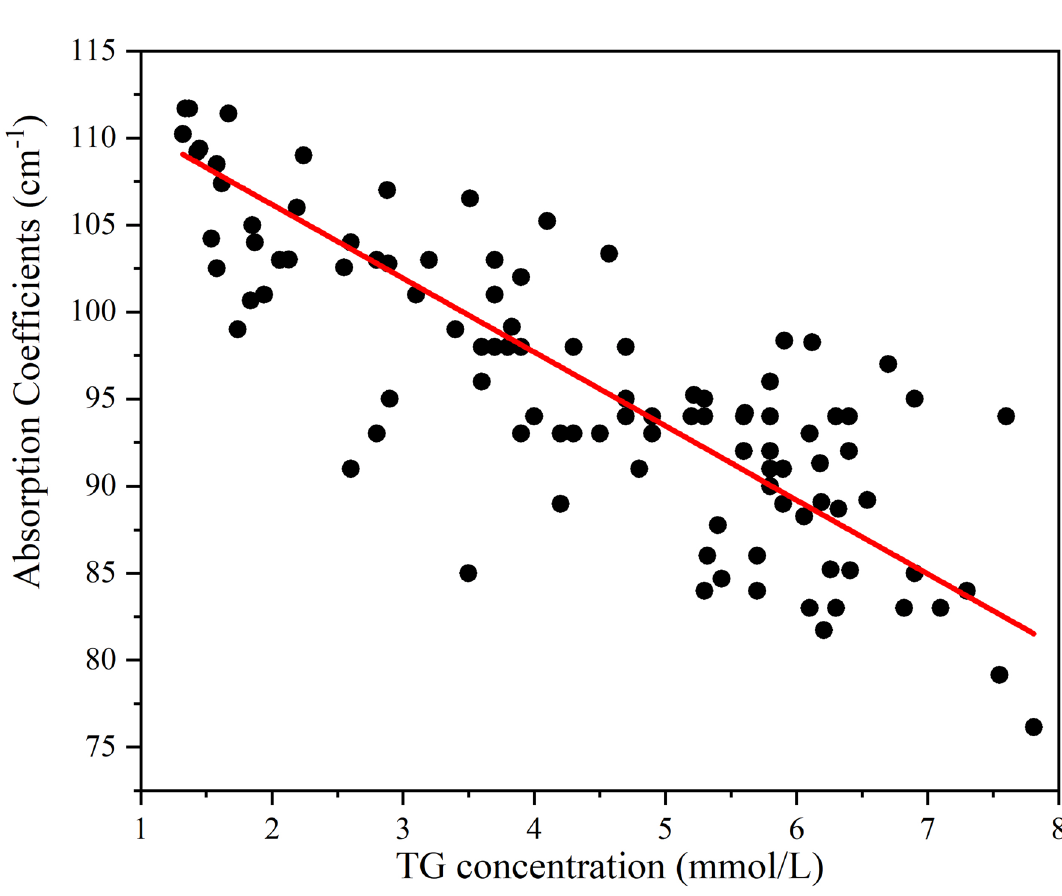
Figure 5. The correlation between the THz wave absorption coefficients and TG concentrations in human